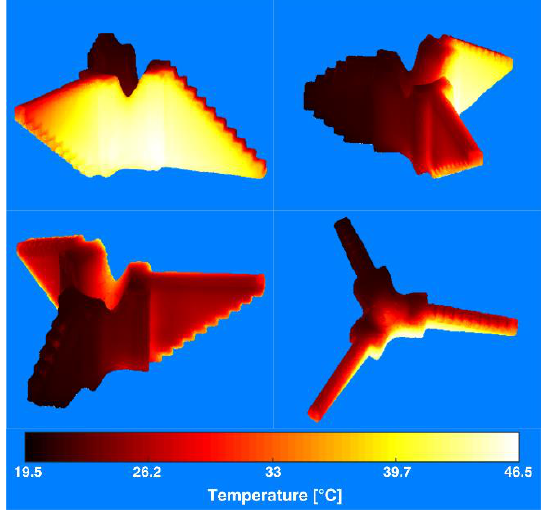
Figure 13. Four different views of the result of the integration of seventeen thermograms. Figure 13. Four di ff erent views of the result of the integration of seventeen